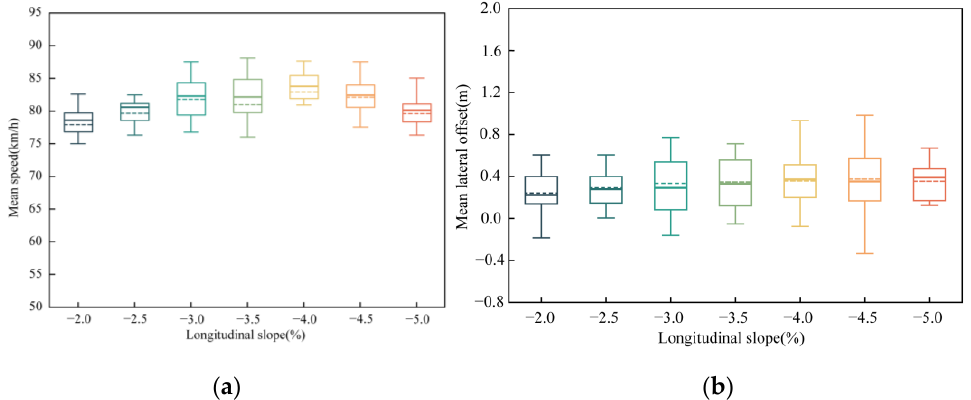
Figure 17. The relationship between driving behavior and longitudinal slope. ( a ) Mean speed. ( b ) Mean lateral offset.